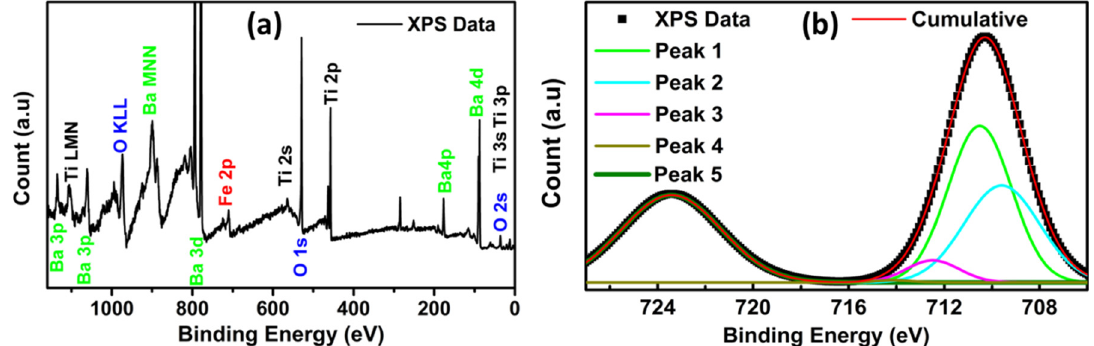
Figure 5. ( a ) Background-subtracted XPS scan of the BaTiO3/iron oxide CSNP. ( b ) Sherley background-subtracted high-resolution scan data of the Fe 2p3/2 orbital deconvoluted without surface peaks.